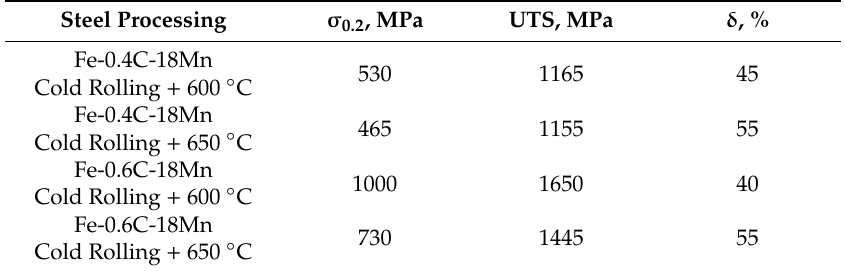
Figure 6. Engineering stress–elongation curves of Fe-0.4C-18Mn and Fe-0.6C-18Mn steels (0.4C and 0.6C, respectively) subjected to cold rolling and annealing at indicated temperatures. Table 2. The yield strength ( σ 0.2 ), ultimate tensile strength (UTS) and total elongation ( δ ).